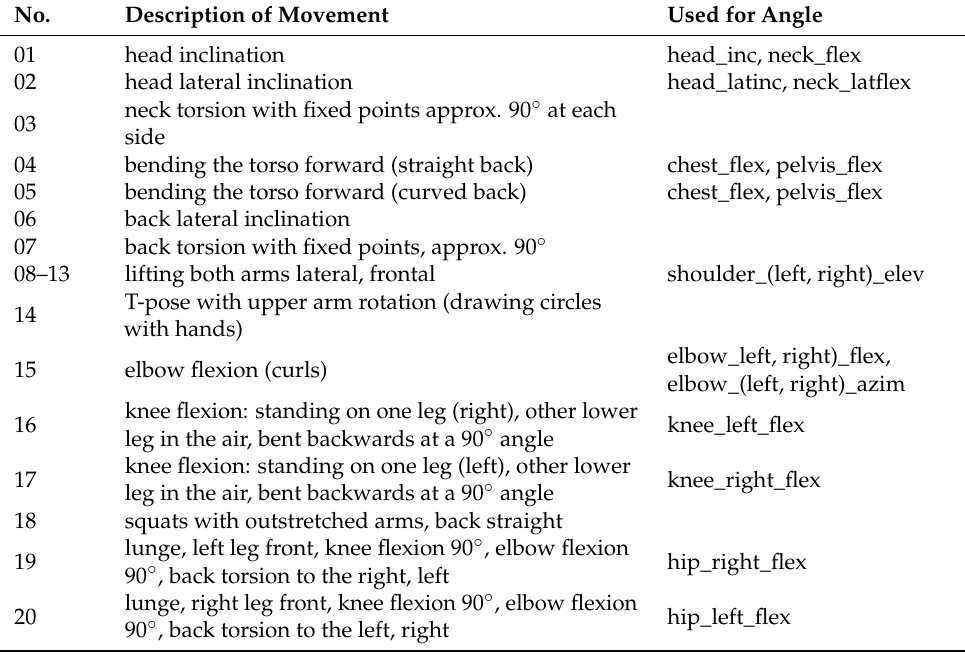
Table 1. Description of the movement segments and associated joint